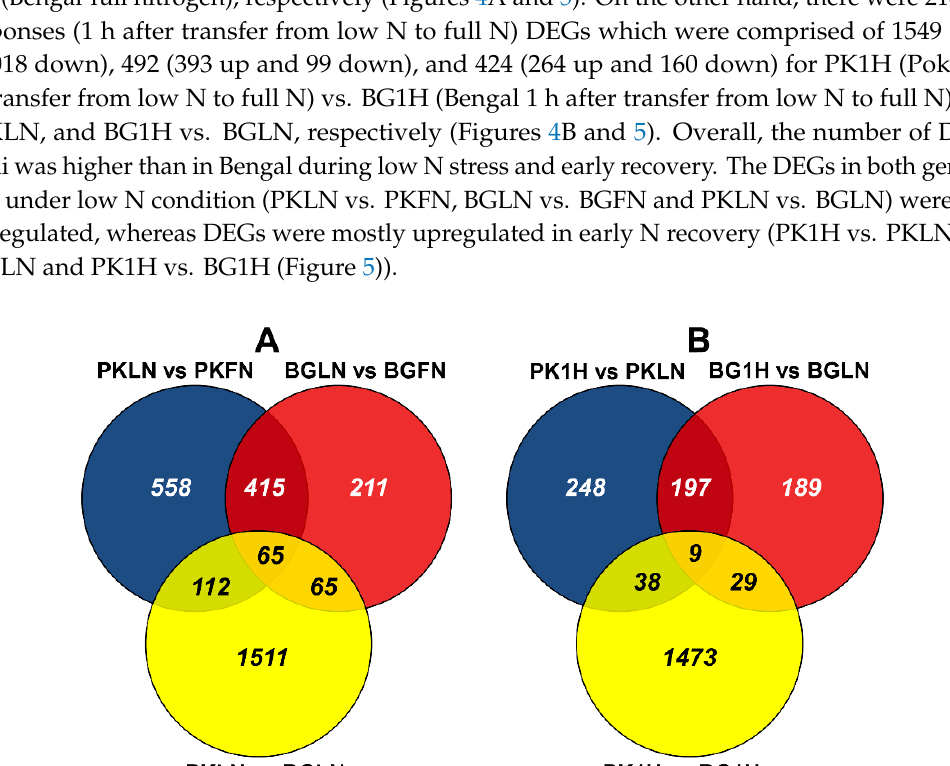
Figure 5. Number of differentially expressed genes in pairwise comparisons of low N and 1-h recovery treatments in Bengal and Pokkali. ( A ) On the stacked bars, blue represents downregulated genes while red represents upregulated genes. ( B ) Combined DEGs of all pairwise comparisons of low N and 1-h recovery treatments in both Bengal (BG) and Pokkali (PK). ( C ) Pokkali-specific DEGs for each treatment. The treatments included in the comparison are PKFN (Pokkali-full nitrogen), PKLN (Pokkali-low nitrogen), PK1H (Pokkali 1-h after transfer from low N to full N), BGFN (Bengal-full nitrogen), BGLN (Bengal-low nitrogen), and BG1H (Bengal 1-h after transfer from low N to full N). Furthermore, the Pokkali-specific N response DEGs were 112 (18 up and 94 down), and 38 (23 up and 15 down) for low N [(PKLN vs. PKFN ∩ PKLN vs. BGLN) – (BGLN vs. BGFN)], and early N recovery [(PK1H vs. PKLN ∩ PK1H vs. BG1H) – (BG1H vs. BGLN)], respectively (Figures 5 and 6). Due to the overlapping of some genes, there were 148 Pokkali-specific DEGs (Table S3). Few genes were common between both N conditions. For example, LOC_Os06g05450 and LOC_Os12g28015 were both regulated during N stress and early recovery. In addition, a literature review of Pokkali-specific DEGs for gene ontology (GO) functions indicated that 9% of genes were involved in plant growth and development whereas the rest were